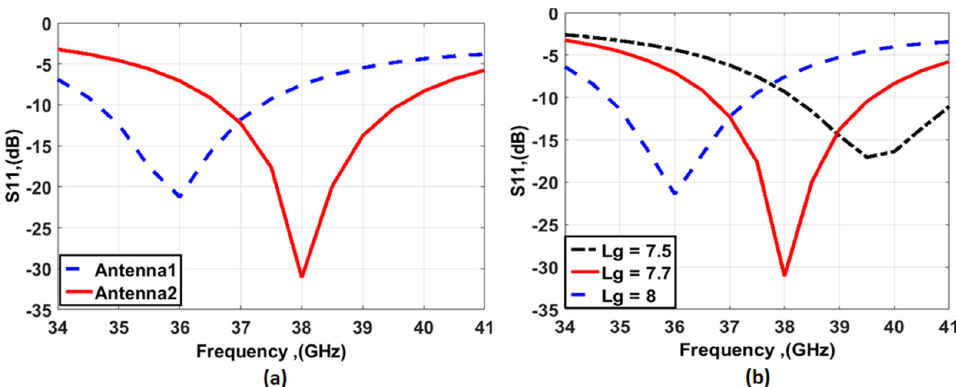
Figure 2. The circular patch antenna results ( a ) S 11 outcomes of the antennas ( b ) The effect of the ground length (Lg).